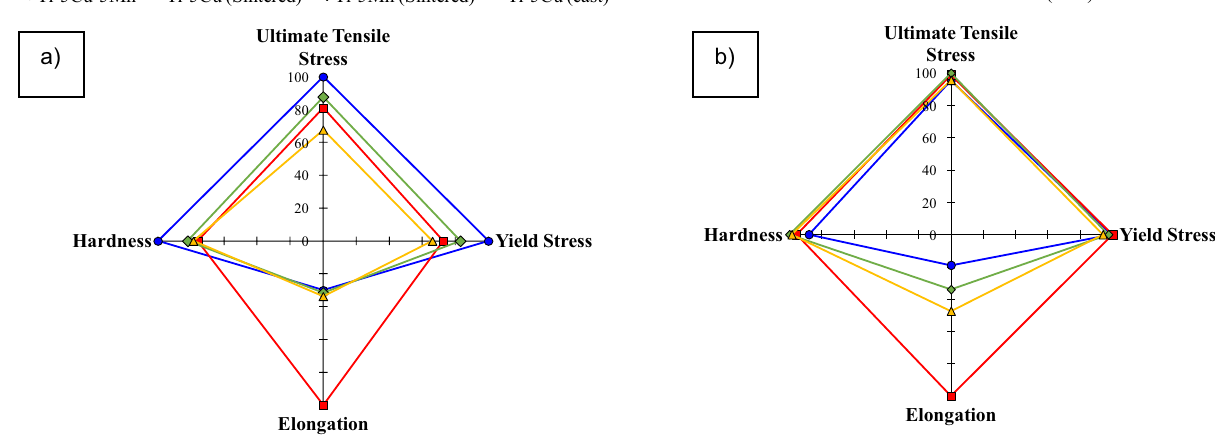
Figure 7. Four-factor radar chart comparing the performance of the β eutectoid bearing functionalised Ti alloys to other Mn- and Cu-bearing titanium alloys ( a ), and other conventional biomedical titanium alloys ( b